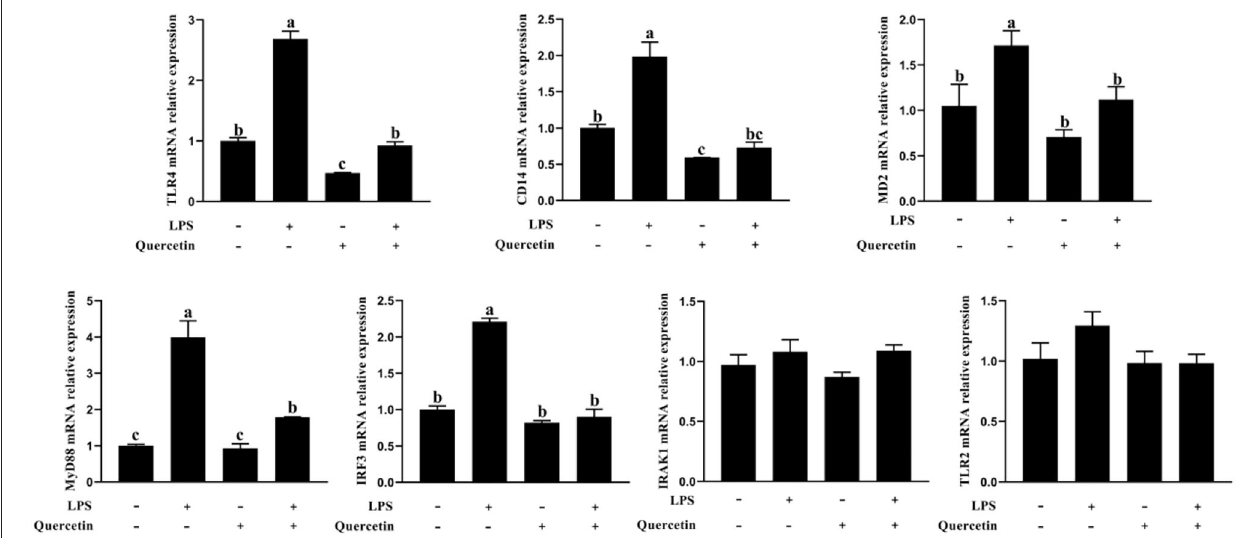
FIGURE 6 | Effects of quercetin on the TLR4 signaling pathway in LPS-induced BMECs. BMECs were treated with 100 µ g/ml of quercetin in the presence of 1 µ g/ml of LPS for 6h. The mRNA expressions of TLR4, TLR2, CD14, MD2, MyD88, IRF3, and IRAK1 in BMEC were assayed by qRT-PCR. Data presented are mean ± SEM ( n = 3). Different lowercase letters in the bar chart indicate significant differences ( P <